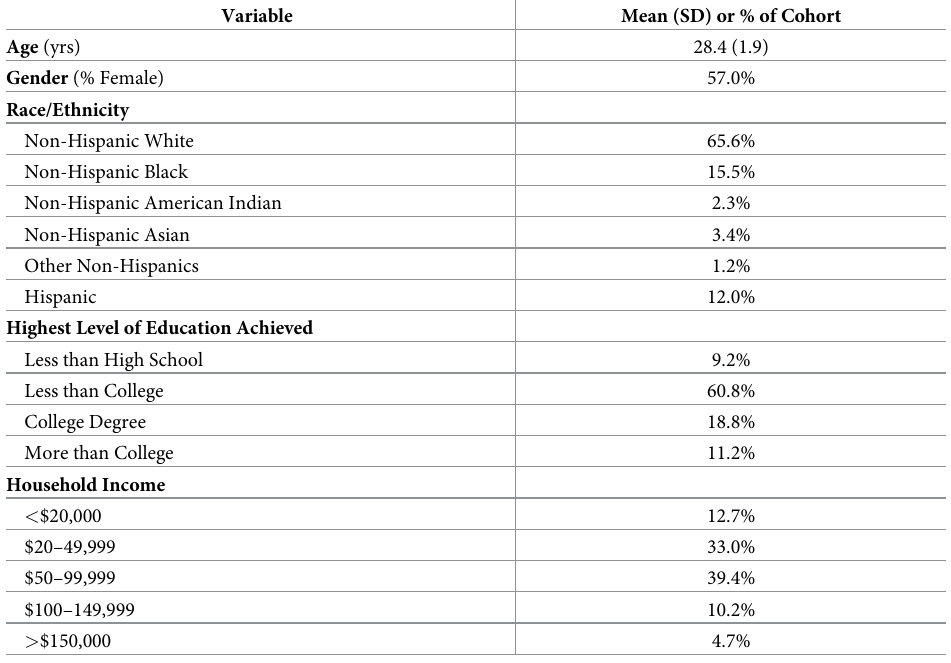
Table 1. Demographic characteristics (N = 15,701).